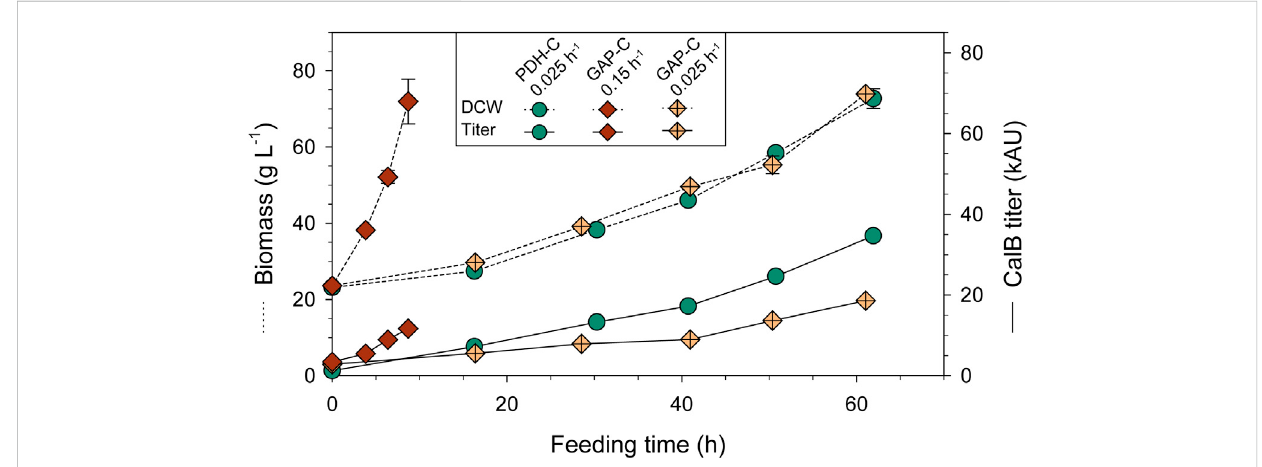
FIGURE 4 BiomassandCalBtitertime-courseofcarbon-limitingfed-batchcultivationswithPDH-Catlowµ(0.025 h -1 )andGAP-Cathigh(0.15 h -1 )andlowµ (0.025 h -1 ). The errors bars represent the standard deviation of the measurements.